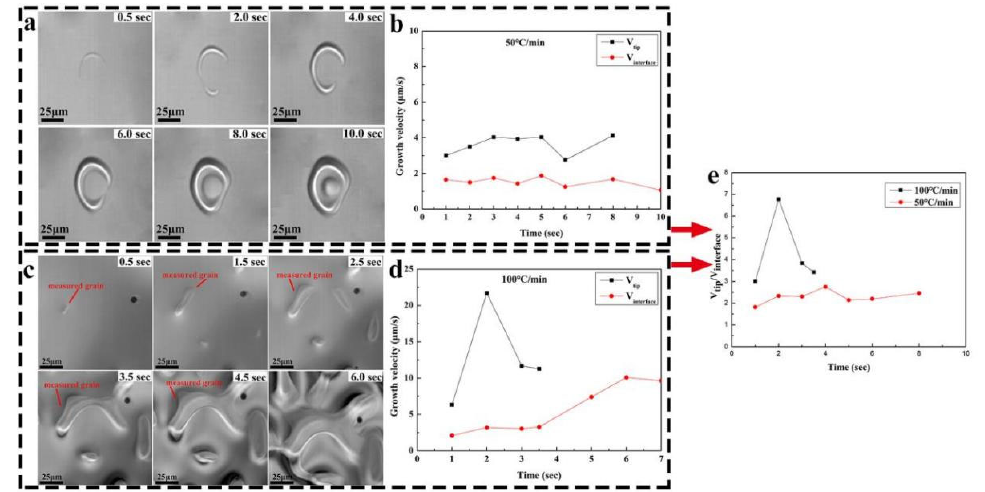
Figure 3. HT-LSCM observation of the growth process of a single austenite grain cooled and growth velocity of a single grain. ( a,b ) for 50°C/min, ( c,d ) for 100°C/min, and ( e ) the ratio of the growth velocity in tip in between interface.